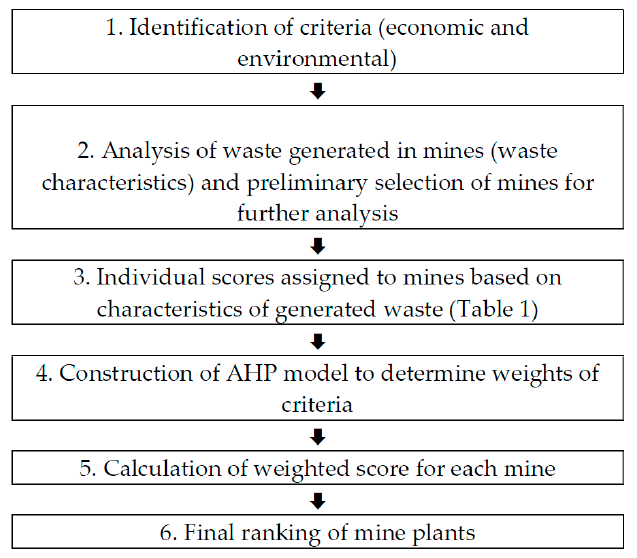
Figure 2. Scheme of methodology adopted in the study for the qualitative analysis of mining waste.